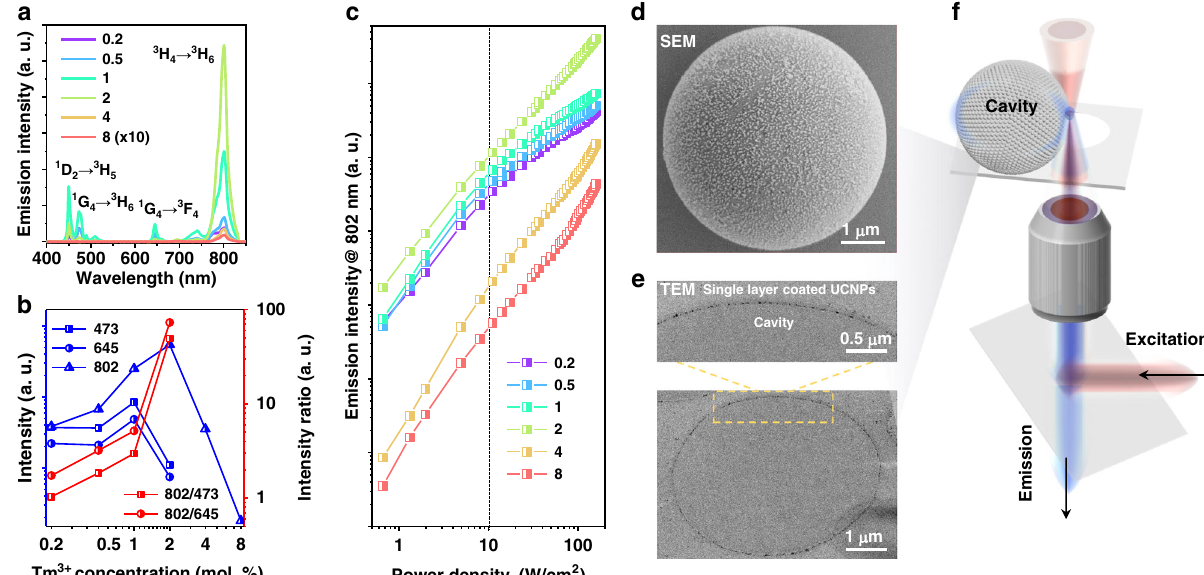
Fig. 2 Power dependent emission characteristics of upconversion nanoparticles with tunable doping concentrations and self-assembled UCNPs as the gain medium on a polystyrene microsphere as the micro cavity. a Comparison emission intensities and spectra of UCNPs doped with 20 mol.% Yb 3 + and x mol.% Tm 3 + (x = 0.2, 0.5, 1, 2, 4, 8). b Comparison emission intensities at the characteristic wavelengths and the intensity ratios of 802 nm/473nm and 802 nm/645nm. Both results displayed in ( a , b ) were acquired at the excitation power density of 100 W/cm 2 . c Power dependent emission intensity evaluation at 802 nm. d SEM image of a 5- μ m polystyrene micro cavity coated with a single layer of self-assembled UCNPs. e Cross-sectional TEM image of micro cavity showing the distribution of UCNPs on the surface. f Excitation and detection scheme (see Supplementary Fig. 5 for the details of a purpose- built imaging and supports both transverse electric (TE) and transverse mag- and cross-sectional TEM measurements of a 5- μ m polystyrene netic (TM) propagating modes with high quality (Q) factor, e.g., microsphere, showing the single layer of 2 mol.% Tm 3 + doped UCNPs on the surface of the cavity through the electrostatic force the Q factor for a 750 μ m fused-silica microsphere could even assembly (see zeta potential data in Supplementary Fig. 9). reach ~10 929 – 32 . When nanoparticles are coated onto the surface, Microsphere con fi nes the light through total internal re fl ection the increased roughness induces scattering losses and reduces Q